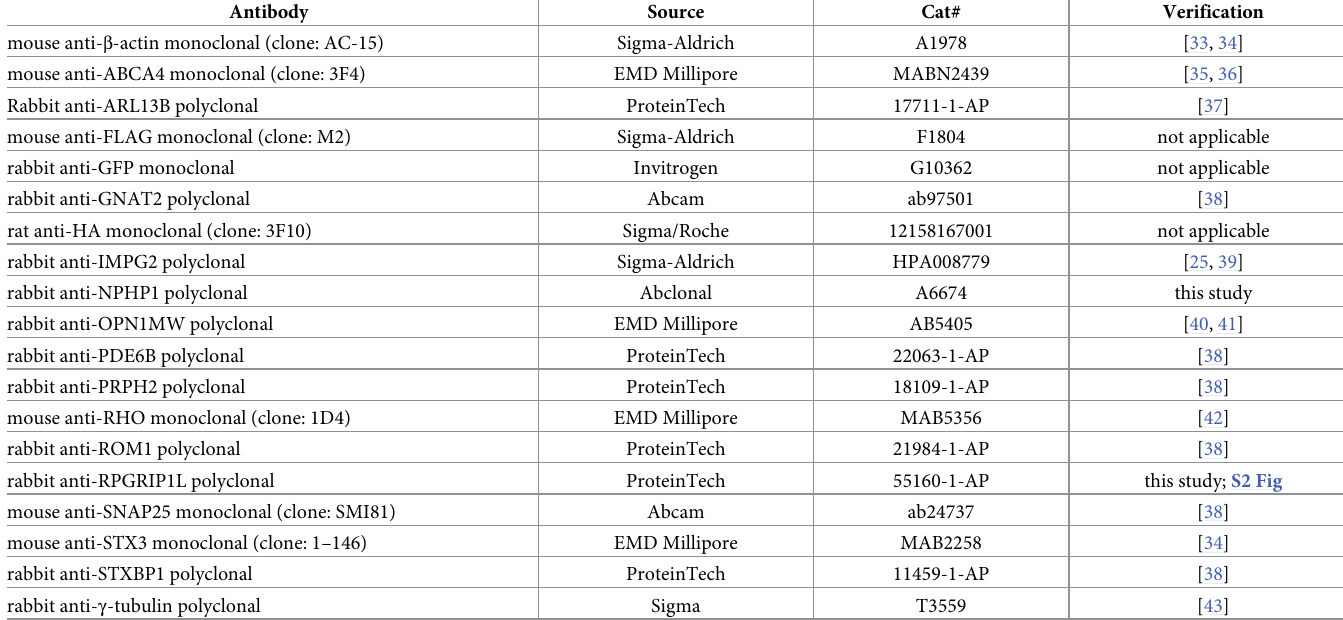
Table 2. Antibodies used in this